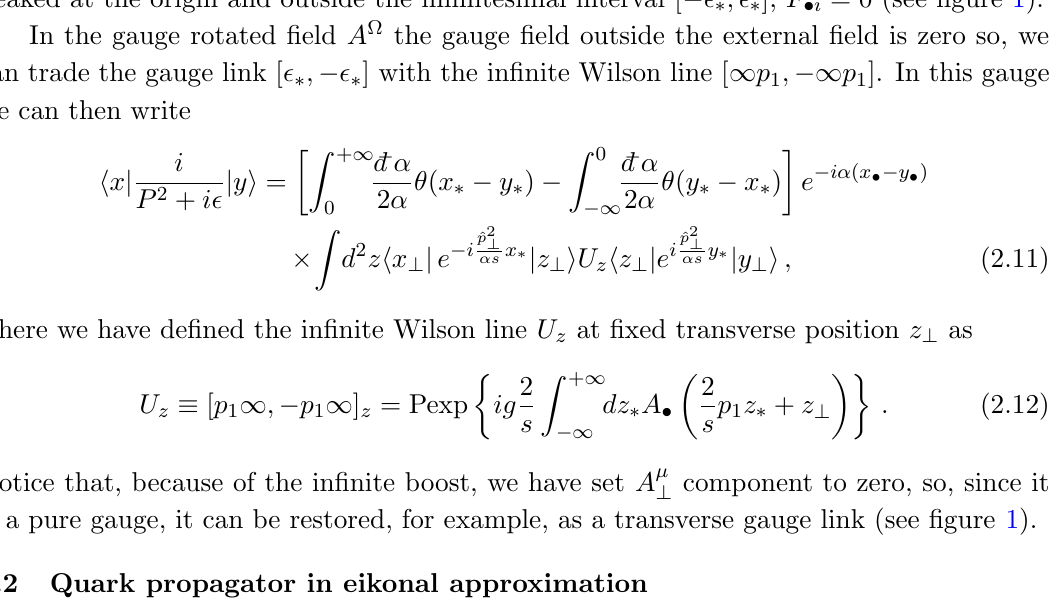
Figure 1 . Particle propagating in an external gluonic (cid:12)eld. The red strip represents the shock-wave de(cid:12)ned in the in(cid:12)nitesimal interval [ (cid:0) (cid:15) (cid:3) ; (cid:15) (cid:3) ] in which F (cid:22)(cid:23) 6 = 0. The light-red areas to the left and to the right of the shock-wave represent the background (cid:12)led made of pure gage (cid:12)eld. The curvy line is the particle’s path from point x to point y . The dotted lines represent the Wilson lines. tensor, F , has an in(cid:12)nitesimal thin support in x coordinate. We assumed that F (cid:15) i (cid:3) (cid:15) i